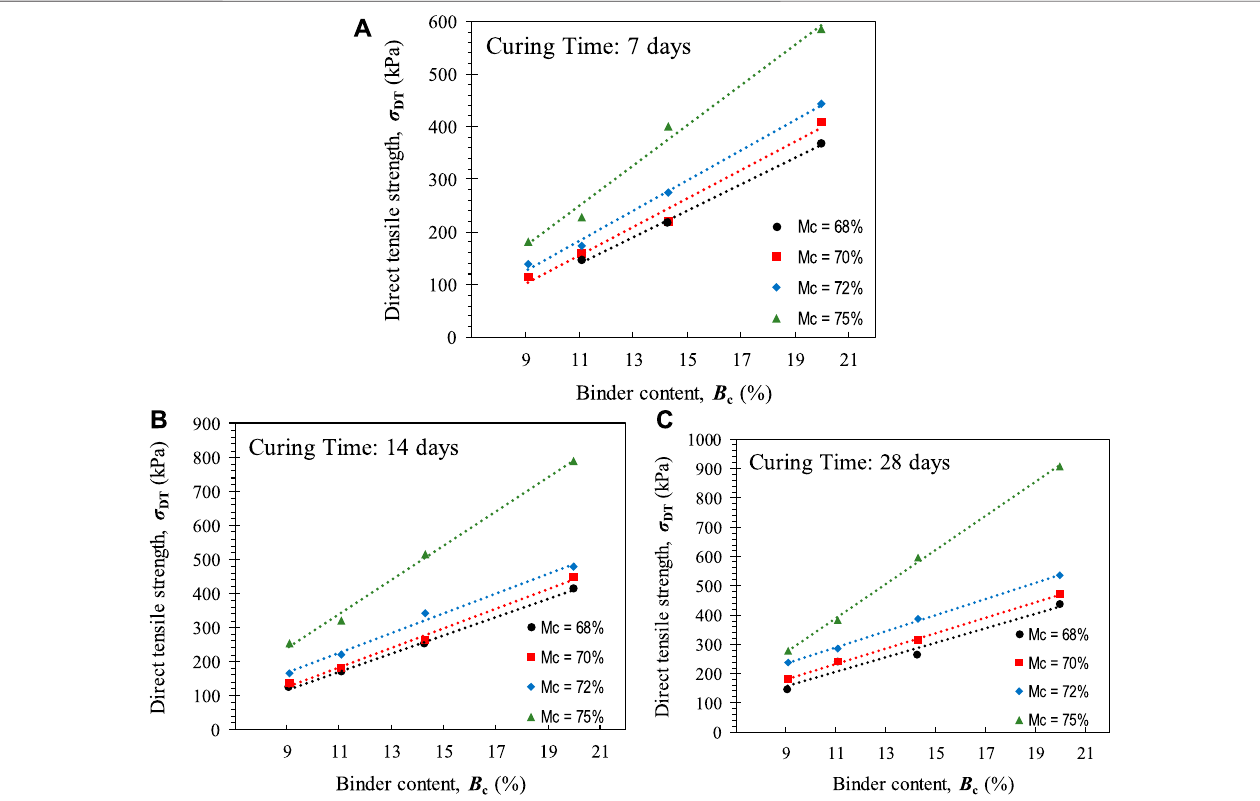
FIGURE7| Variationsofdirecttensilestrength σ DTagainstthebindercontentwithdifferentsolidmasscontentsforsamplescuredfor (A) 7 days, (B) 14 days,and (C) 28 days.